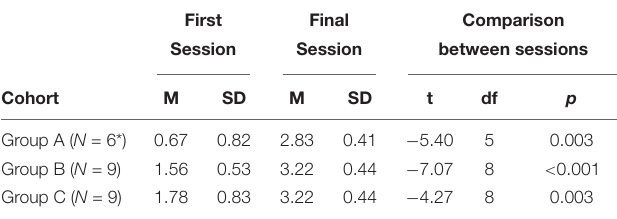
TABLE 2 | Cohesiveness at the beginning and end of the intervention, by group.